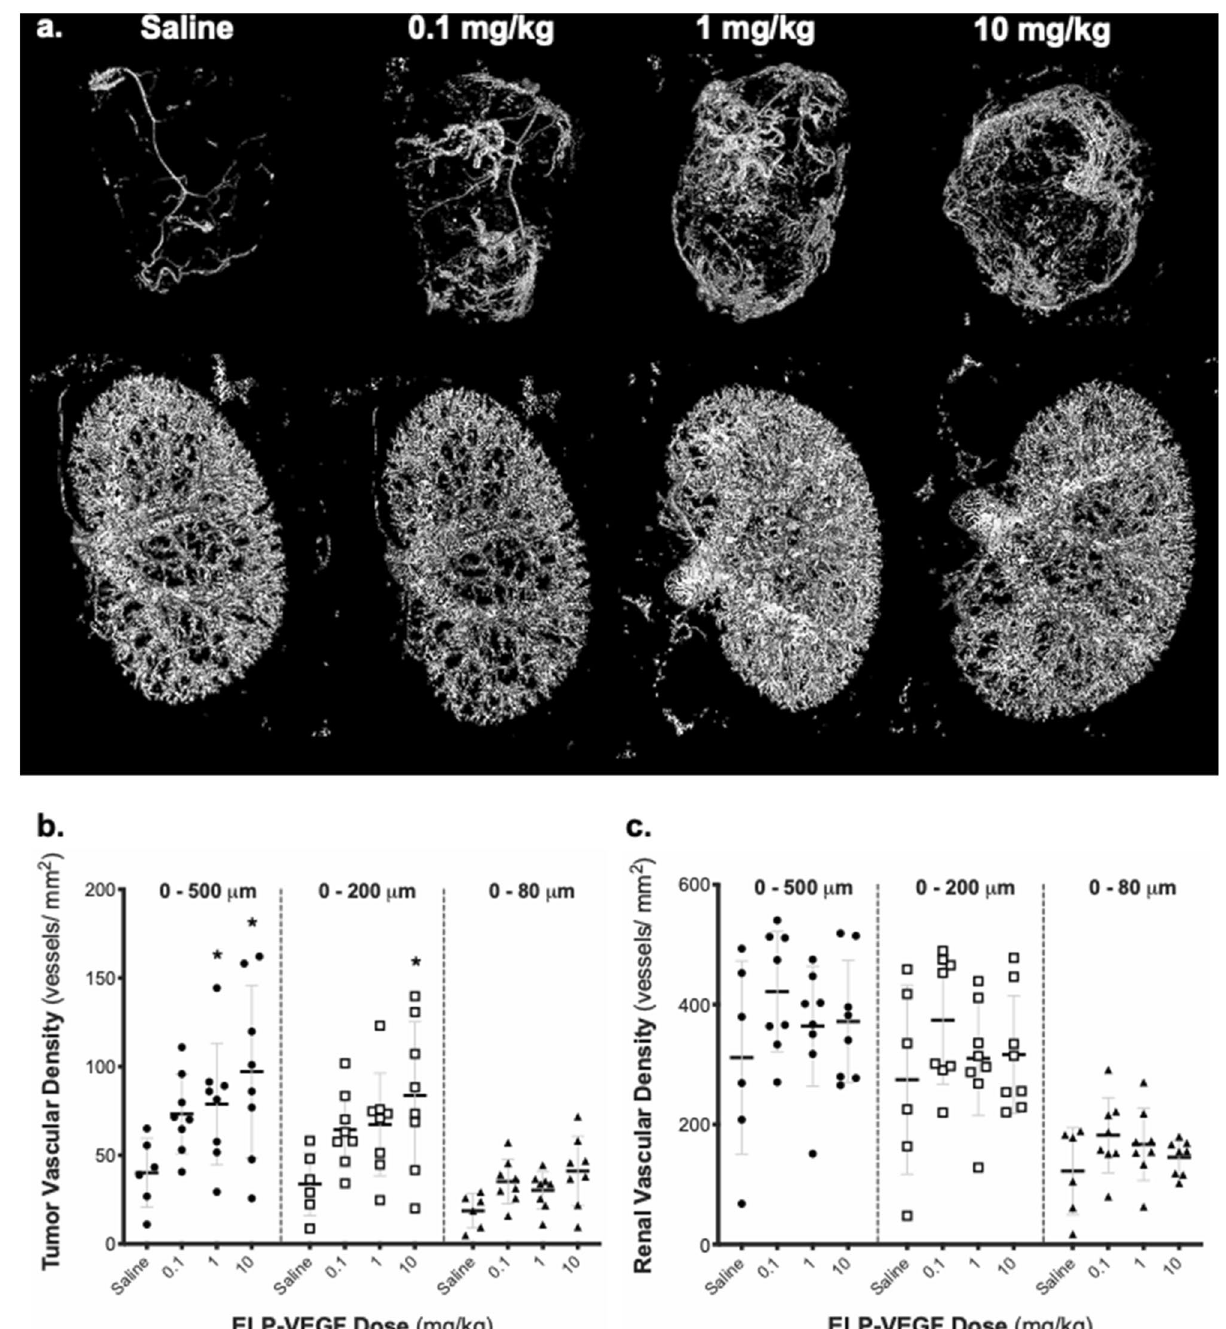
Figure 8. Effect of ELP-VEGF on Breast Tumor and Renal Vascular Density in Nude Mice. Vascular density in MDA-MB-231 breast tumors ( a , top panel and quantified in b ) and mouse kidneys ( a bottom panel and quantified in c ) was assessed five weeks after a single bolus ELP-VEGF injection at increasing doses by μCT scanning. * Statistically significant decrease relative to saline treated rats, p < 0.05, two-way ANOVA with post- hoc Dunnett correction for multiple